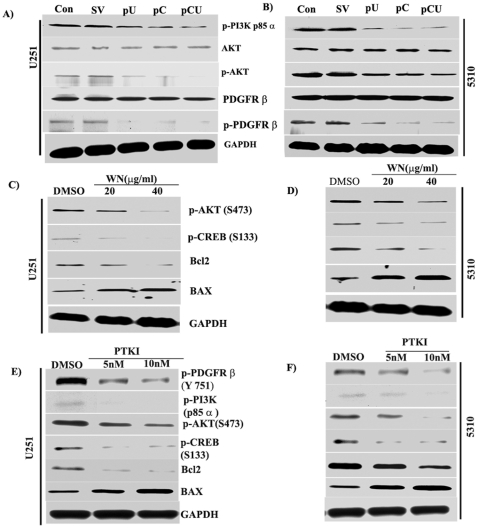
Downregulation of uPAR and cathepsin B using siRNA interferes with intracellular signaling events.U251 and 5310 cells were transfected with SV, pU, pC or pCU. Untreated cells served as the control. After 72 hrs, cells were collected, and total cell lysates were prepared and western blotted as per standard protocol using normal and phosphorylated forms of PI3K, Akt and PDGFR-β. (A–B) Expression of normal and phosphorylated forms of PI3K, Akt and PDGFR-β in U251 and 5310 cells. Columns: mean of triplicate experiments; bars: SE; *p<005 and **p<0.001, significant difference from untreated control or SV-transfected control. Effect of PI3K inhibitor (Wortmannin) and PDGFR tyrosine kinase inhibitor (PTKI) on expression of p-PDGFR-β, p-PI3K p85α, Bcl-2 and Bax. U251 and 5310 cells were treated with 20 and 40 µg/mL of PI3K inhibitor (Wortmannin;WN) for 48 hrs, and the expression levels of p-Akt, p-CREB, Bcl-2 and Bax were determined by western blotting using appropriate antibodies. (C–D) Western blot analysis of p-AKT, p-CREB, Bcl-2 and Bax expression levels after treatment with the PI3K inhibitor. Separately, U251 and 5310 cells were treated with 5 nM and 10 nM PDGFR tyrosine kinase inhibitor (PTKI) for 48 hrs. Expression levels of p-PDGFR-β, p-PI3K, p-Akt, p-CREB, Bcl-2 and Bax were determined by western blotting using appropriate antibodies. (E–F) Western blot analysis of p-PDGFR-β, p-PI3K, p-Akt, p-CREB, Bcl-2 and Bax expression levels in U251 and 5310 cells treated with PDGFR tyrosine kinase inhibitor.